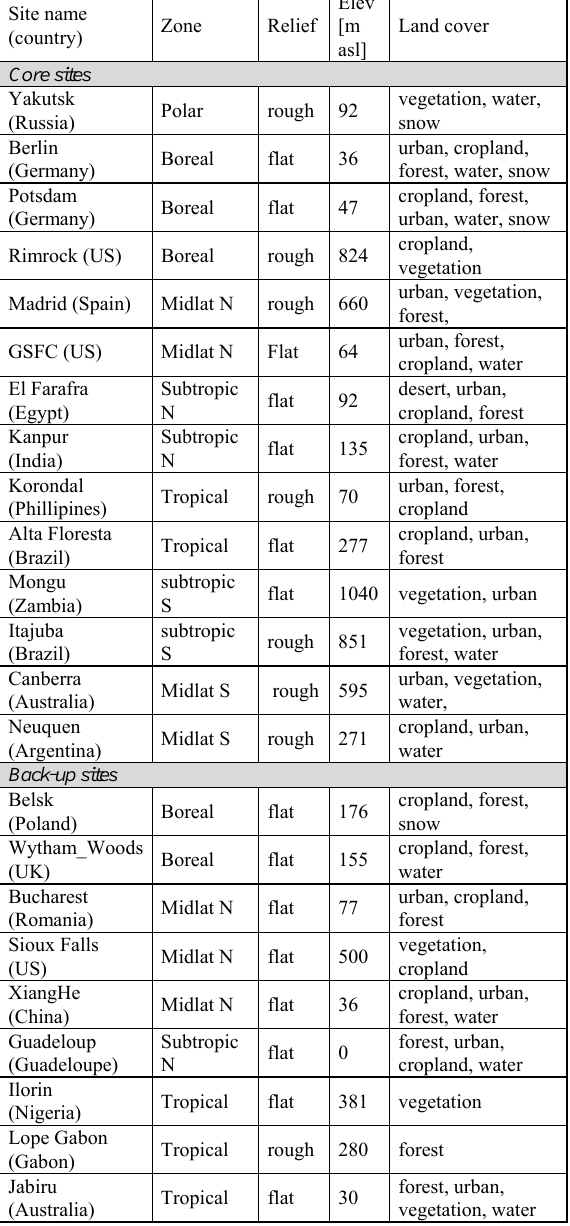
Table 4. Selected core and back-up Aeronet test-sites for AOT and WV L2A products validation.